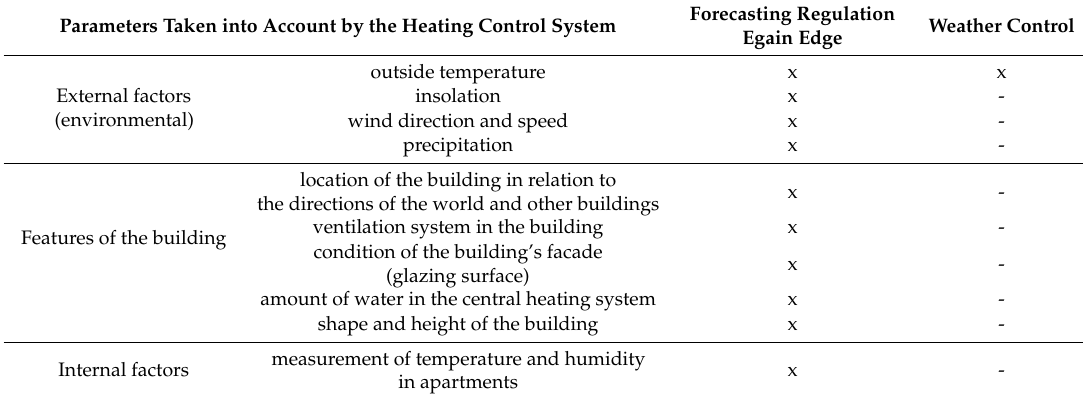
Table 2. Compilation and comparison of elements included in heating regulation systems [19].